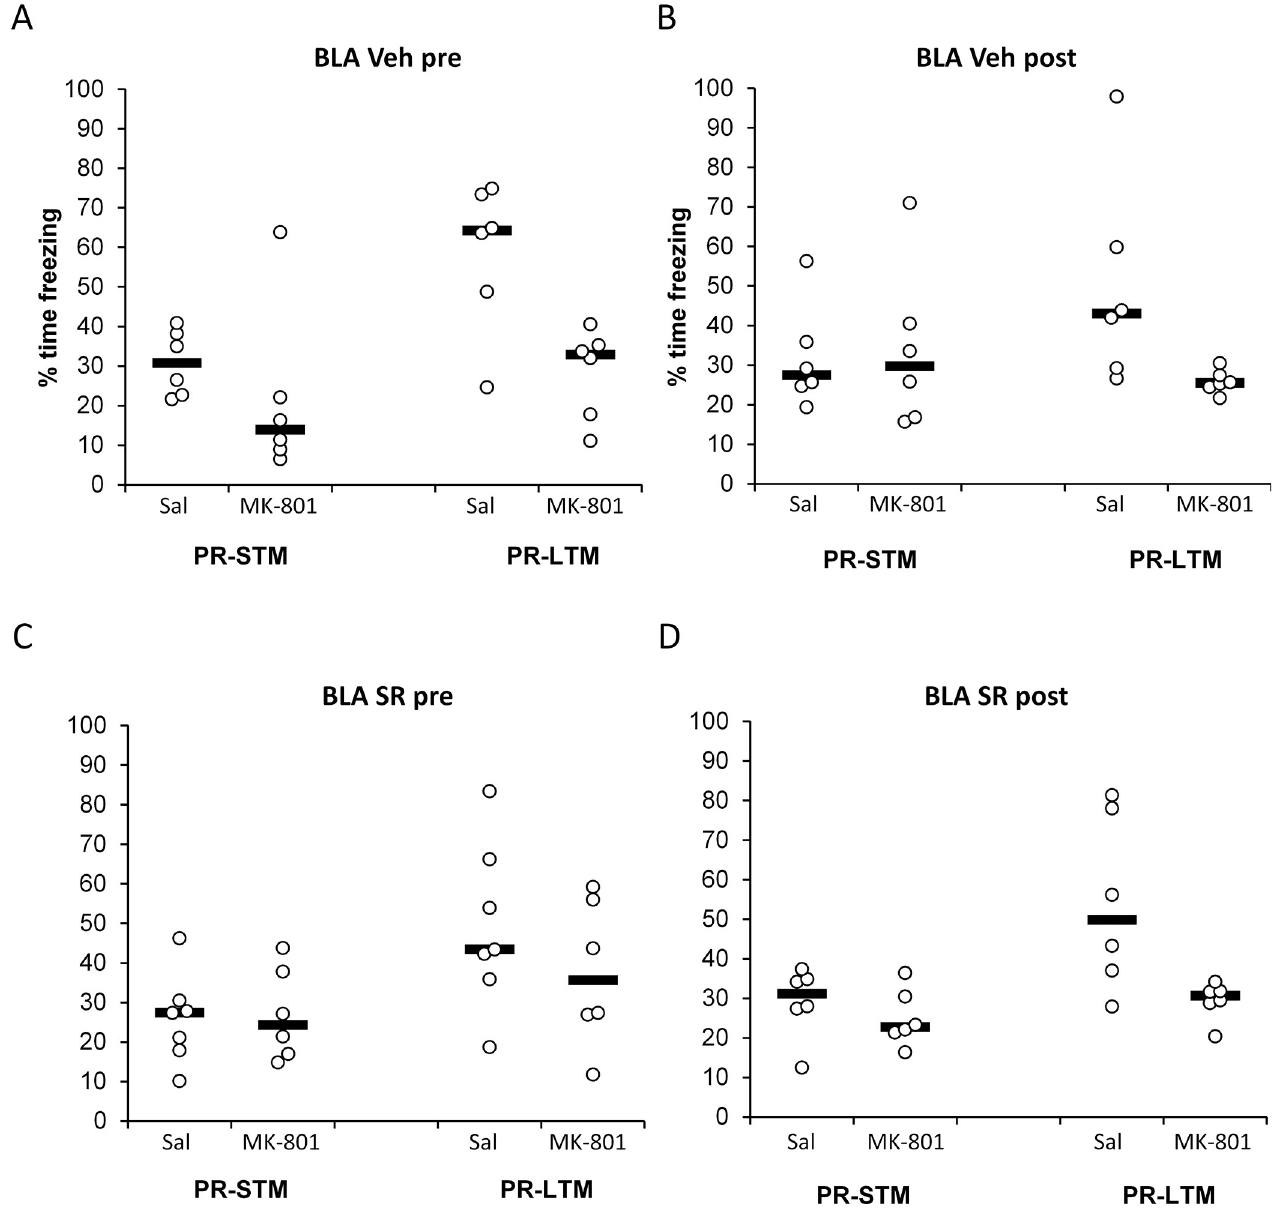
Fig 2. CB1 receptor antagonism in the basolateral amygdala impairs memory destabilization when performed before memory reactivation. MK-801 injection (0.1 mg/ml, i.p.) impaired memory reconsolidation in the long-term memory test (PR-LTM) in the groups infused with vehicle either before (A; simple main effect of injection, p = 0.006) or immediately after (B; p = 0.023) memory reactivation. While pre-reactivation infusion of SR141716A (8 μ g/ μ l) seemed to prevent the amnestic effect of MK-801 (C; p = 0.25), post-reactivation infusion did not (D; p = 0.021. However, there was no significant interaction between the timing of infusion and the effect of MK-801 (Timing x Infusion x Injection: F(1,41) = 1.11, p = 0.30, η 2 p = 0.026). No effect of MK-801 injection or SR141716A infusion is observed in the short-memory test at 3h (PR-STM). Data are presented as individual units and mean. n = 6 per group, except for pre- reactivation SR141716 + Saline, in which n =